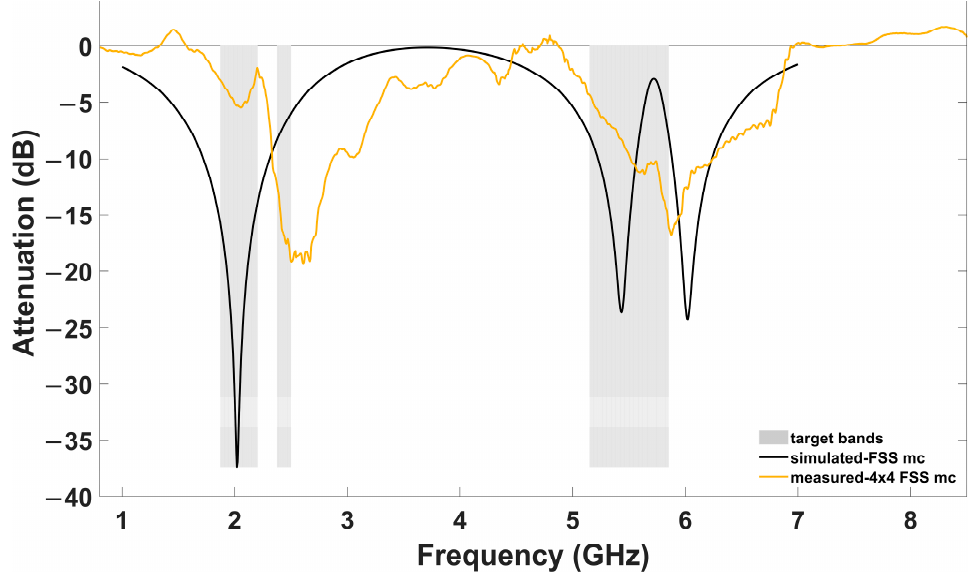
Figure 7. Floquet mode simulation vs. measure of the unspaced 4 × 4 FSS design for antenna isolation.